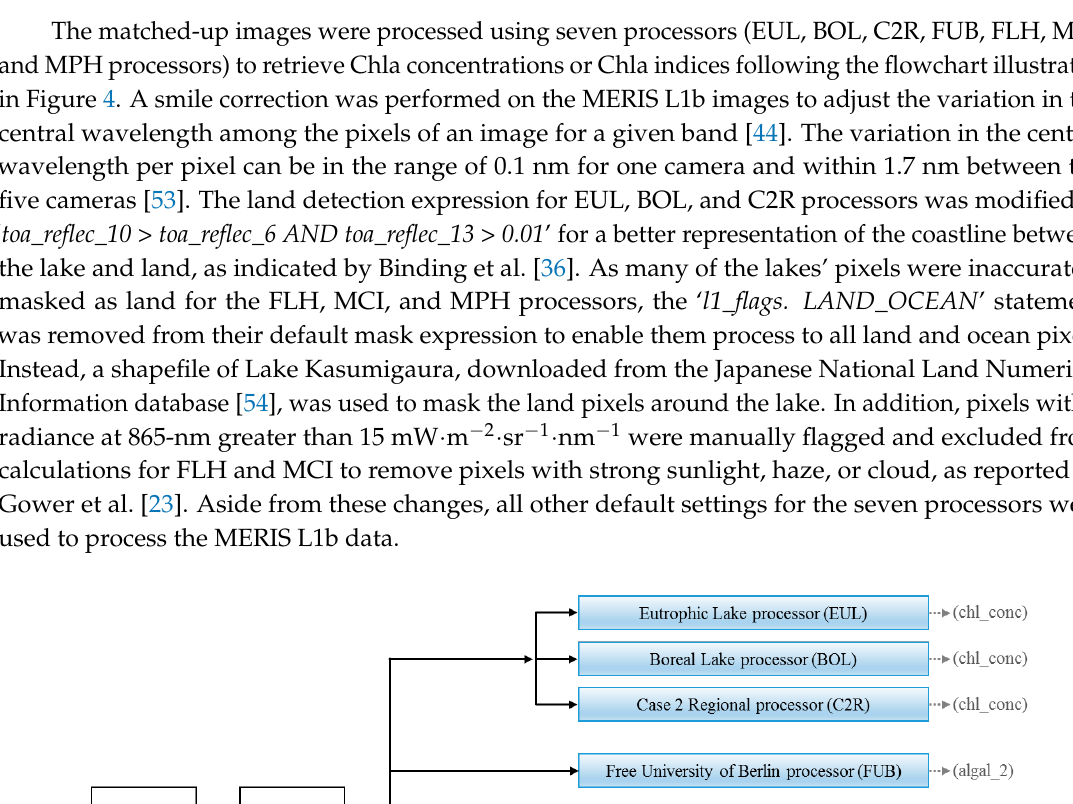
Figure 4. Processing flowchart of MERIS L1b images to retrieve chlorophyll-a concentrations or indices related to chlorophyll-a concentrations using neural network and band height processors. chl_conc indicates the chlorophyll-a (Chla) concentration retrieved from the EUL, BOL, and C2R processors; algal_2, and chl stand for the retrieved Chla of FUB and MPH processors, respectively; and FLH and MCI denote indices correlated with Chla concentrations.